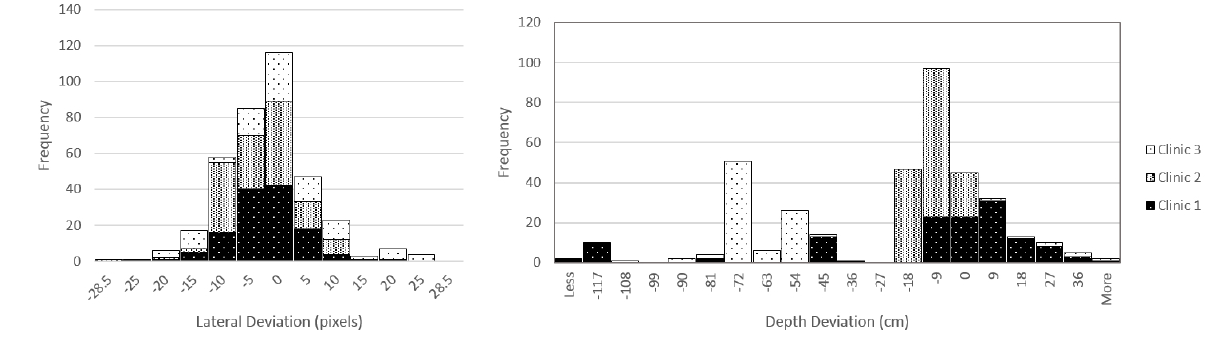
Table 6. Mean examination length of the first and final examinations of all health professionals and of nurses and doctors separately.